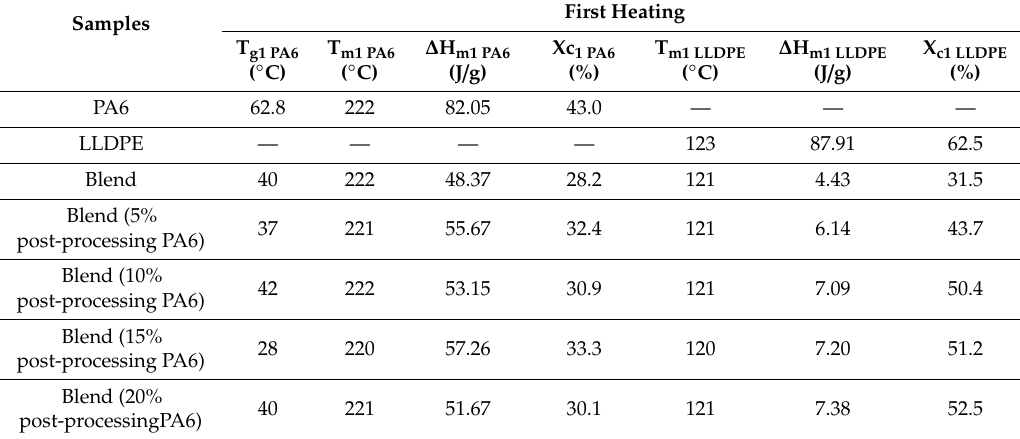
Figure 5. DSC thermograms of neat PA6, neat LLDPE and the blends. ( a ) First heating, ( b ) cooling and ( c ) second heating. Table 3. Values of T g , T m , ∆ H m and X c of neat PA6, neat LLDPE and the blends obtained during first heating.